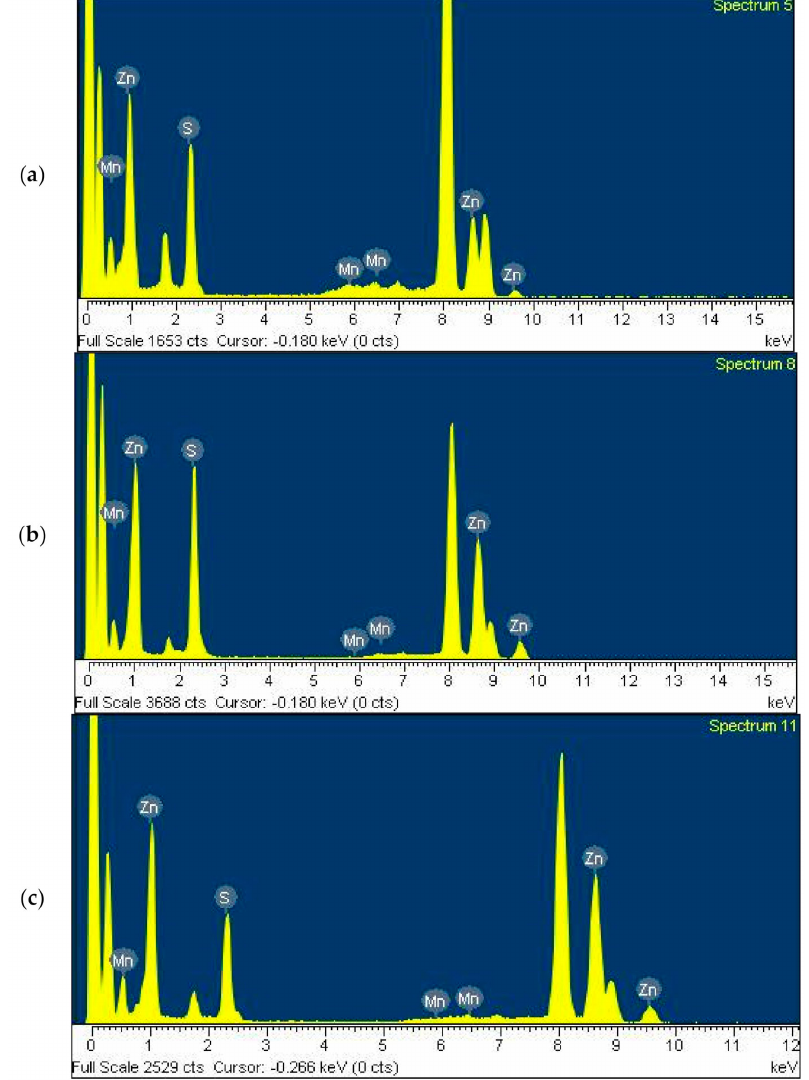
Figure 3. EDXS diagrams of ( a ) Gly-ZnS:Mn, ( b ) Ala-ZnS:Mn, and ( c ) Val-ZnS:Mn